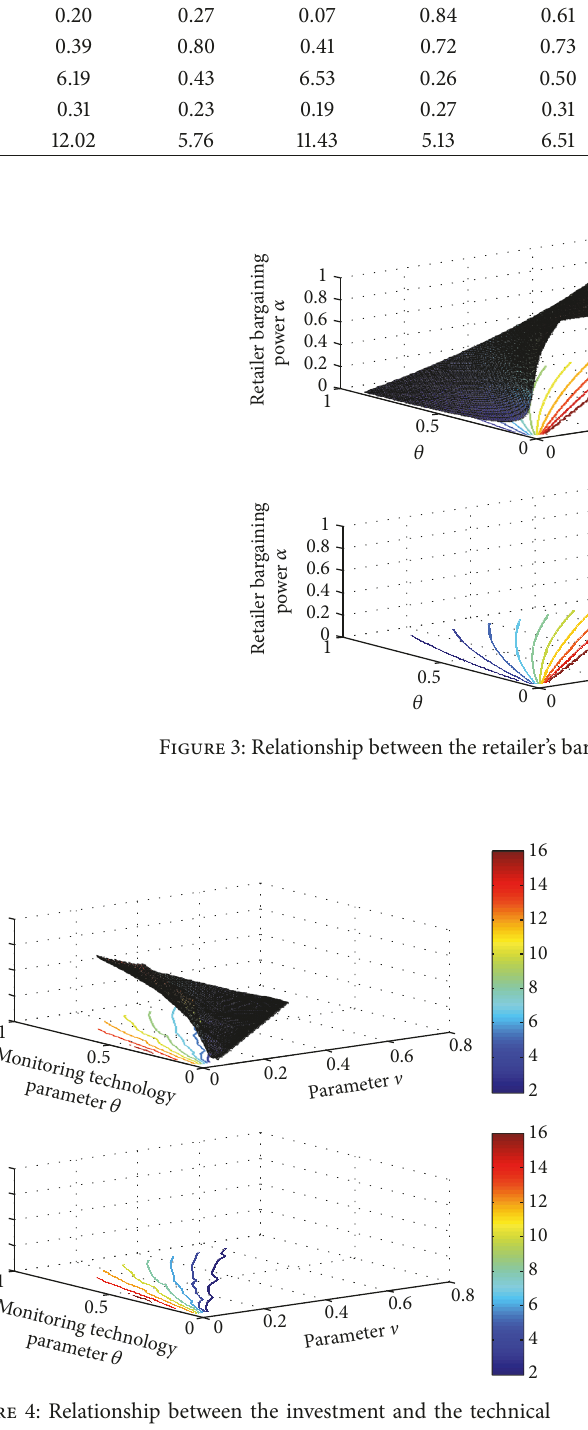
Figure 4: Relationship between the investment and the technical